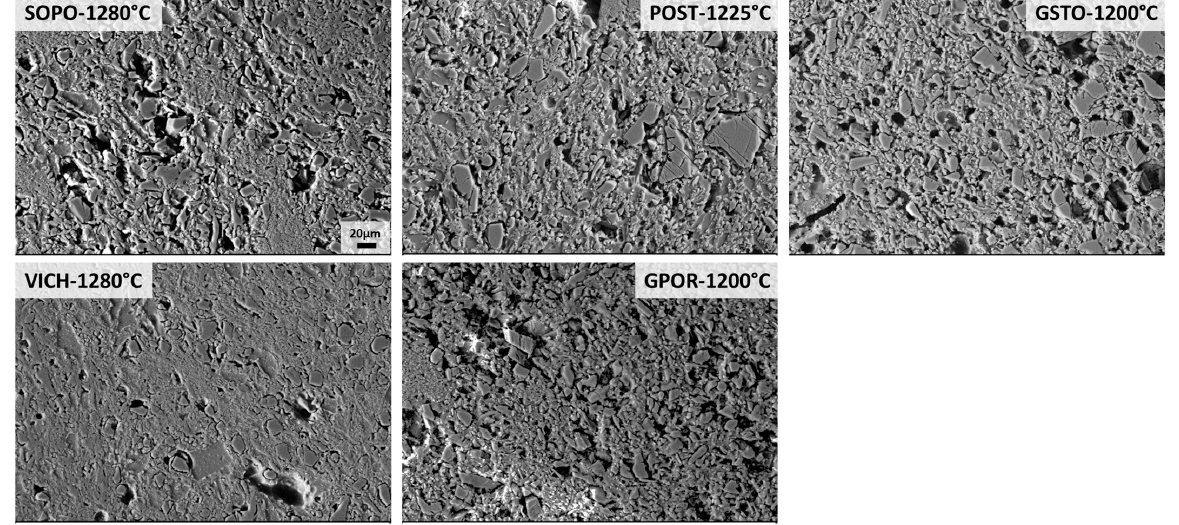
Figure 7. SEM micrographs of densified bodies after HF etching (scale bar = 20 µm). Figure 8. Different features allow to discriminate SOPO-VICH from POST-GPOR-GSTO,